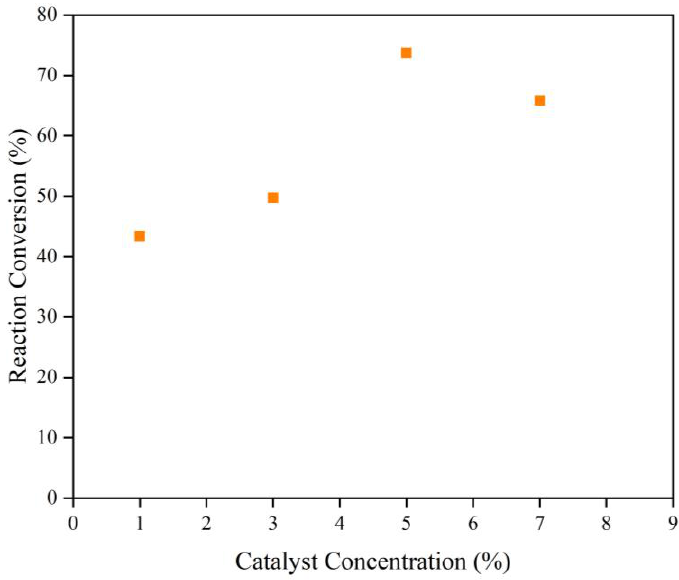
Figure 2. Effect of the Catalyst Concentration on the Reaction Conversion of FFA Esterification in CSO over SnCl 2 .2H 2 O Catalyst at the Reaction Temperature of 60 °C, Molar Ratio of CSO and methanol of 1:30, and Reaction Time of 120 min.